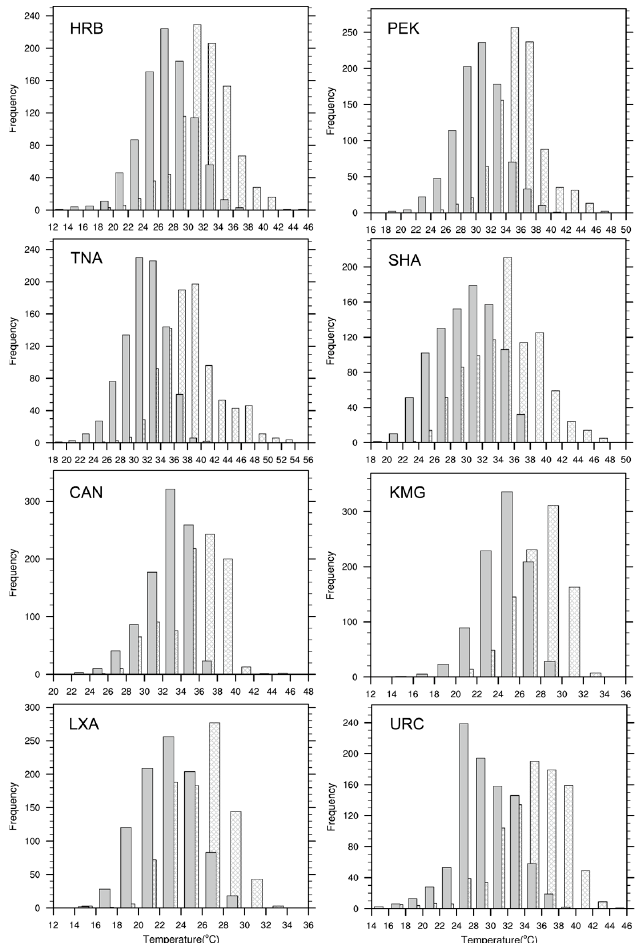
Figure 4. The distribution of summer daily maximum surface air temperature during 1991 − 2000 (gray bar) and 2071 − 2080 (criss-cross bar).